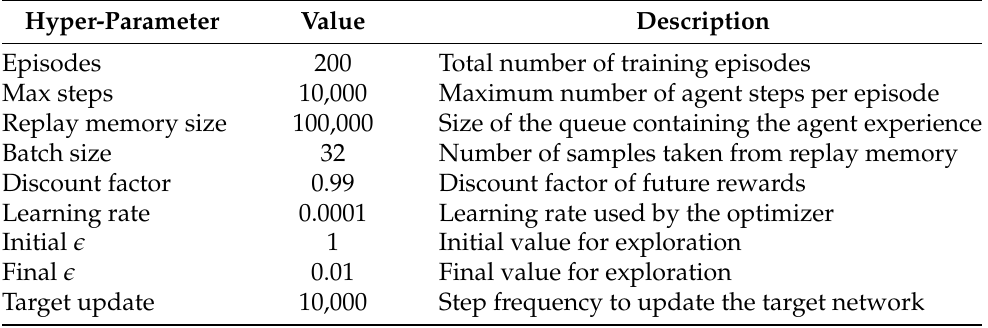
Table 1. Hyper-parameters for the Deep Q-learning